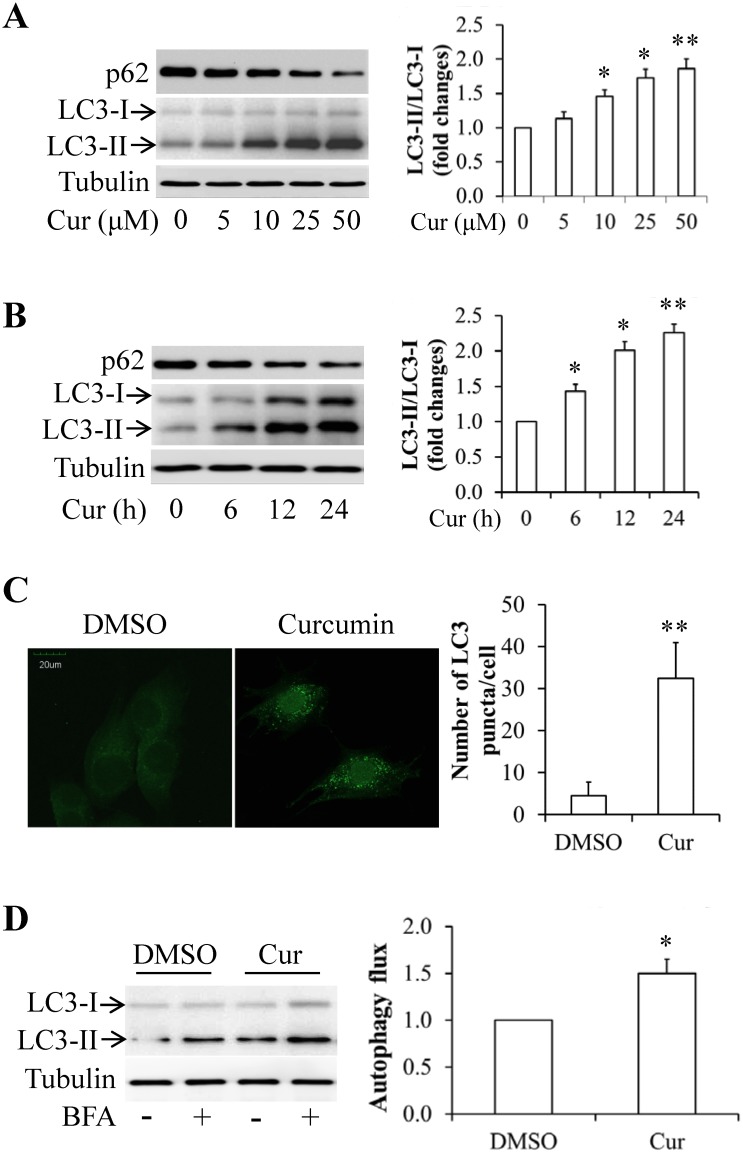
Effect of curcumin on autophagy in MDA-MB-231 cells.(A and B) Protein expressions of autophagy marker p62 and LC3. Left panel are the representative images of western blot. Right panels are LC3-II/LC3-I ratio analyzed quantitatively in a bar graph. (C) GFP-LC3 puncta formation. Left panel is representative images of GFP-LC3 puncta. Right panel is a quantitative analysis of dot number in cells. (D) Autophagic flux. Left panel is a representative western blot band of LC3. Right panel is a quantitative analysis of autophagy flux. Autophagic flux was determined by calculating the difference in LC3-II turnover between the experimental groups. Data are means ± SEM. (n = 4).* p<0.05, ** p<0.01 vs DMSO control.